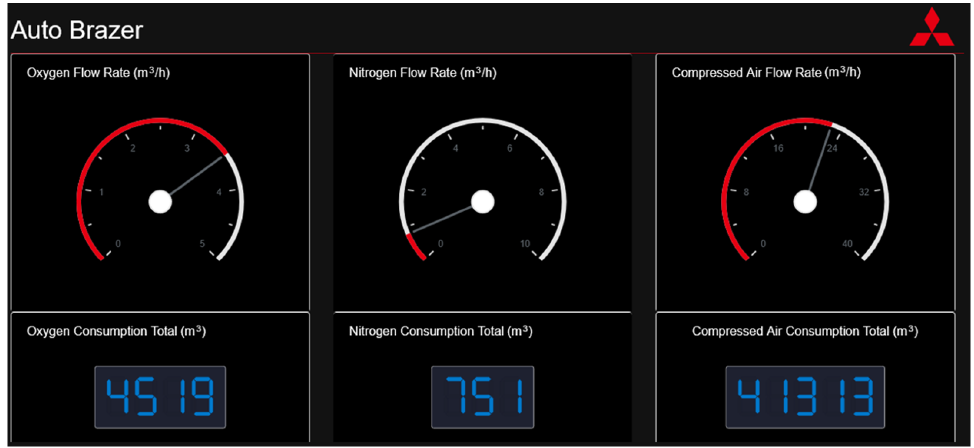
Figure 7. Python Web Dash with live machine data.